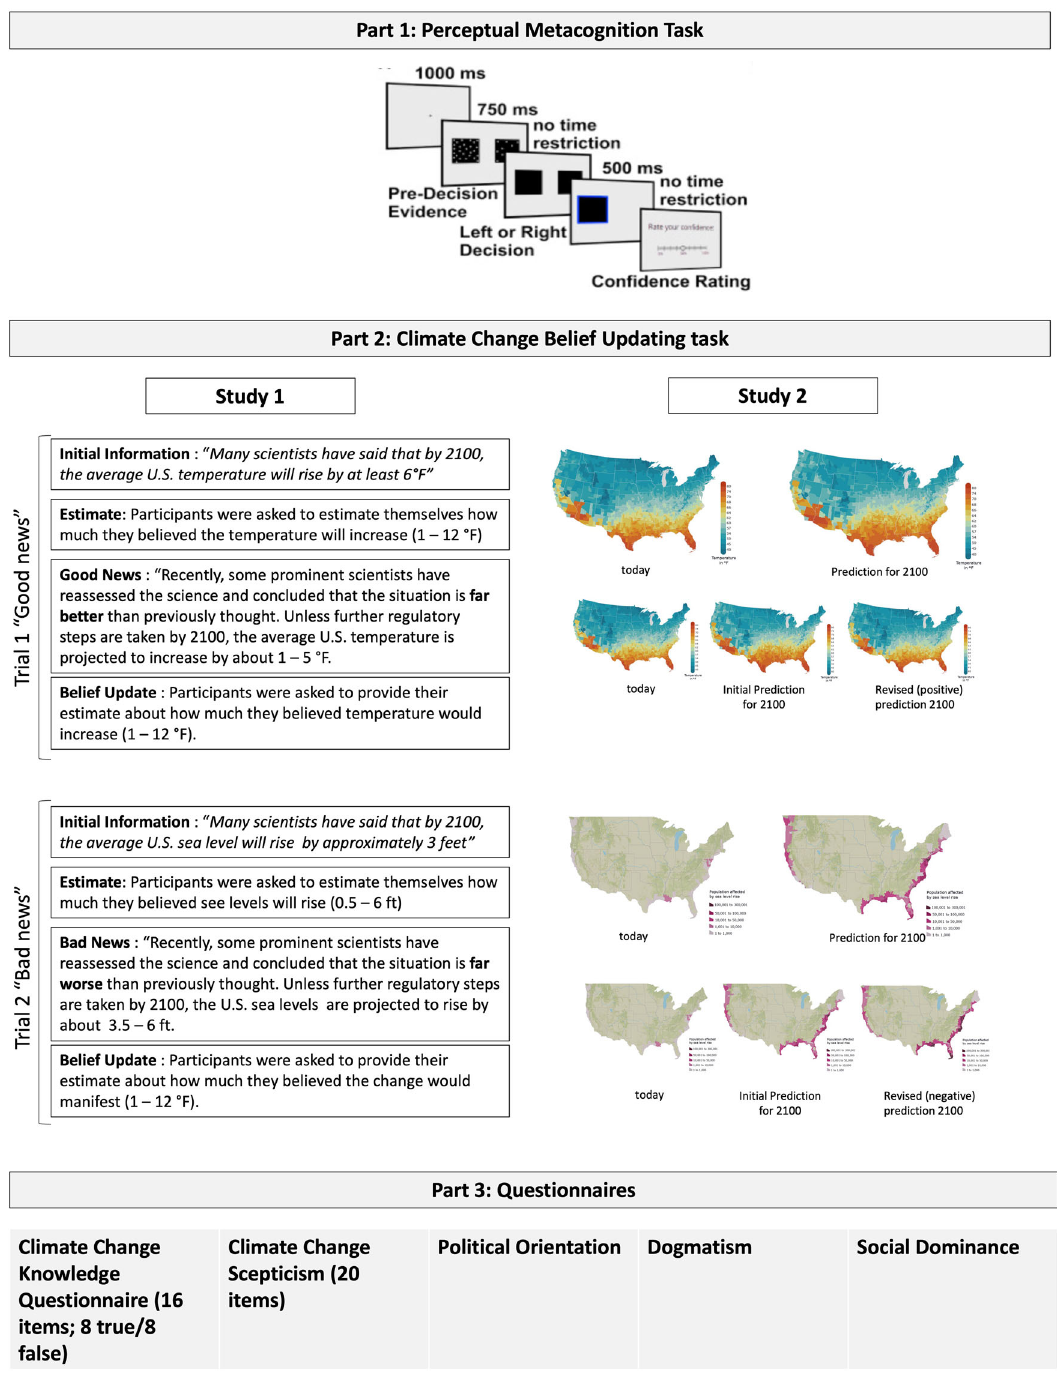
Fig. 1 Experimental design. We carried out two studies with an identical design except for the modality used in the belief-updating task, where climate change information was either communicated with textual-only (Study 1) or visuo-textual (Study 2) information to participants. Participants were exposed to either good or bad news and had to estimate the impact of climate change in two different scenarios. We measured if and how they updated their beliefs in response to good or bad